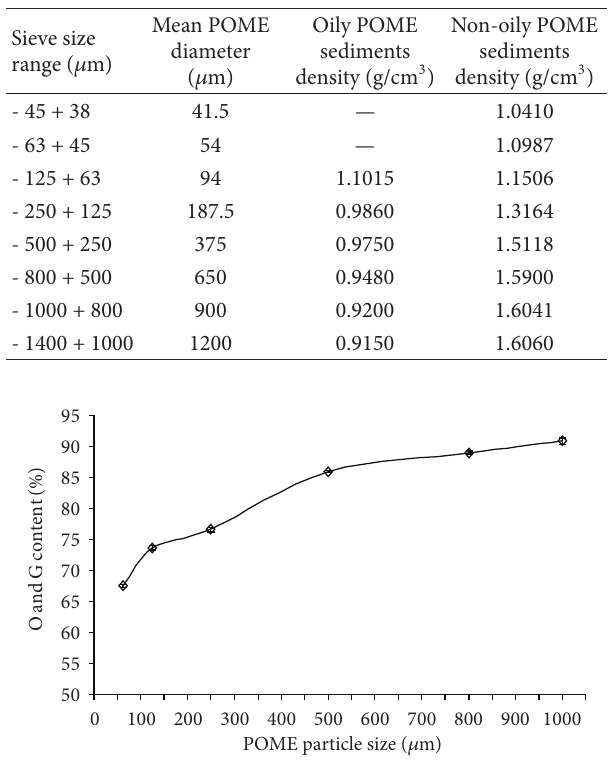
T 7: e densities of oily and non-oily POME sediments.